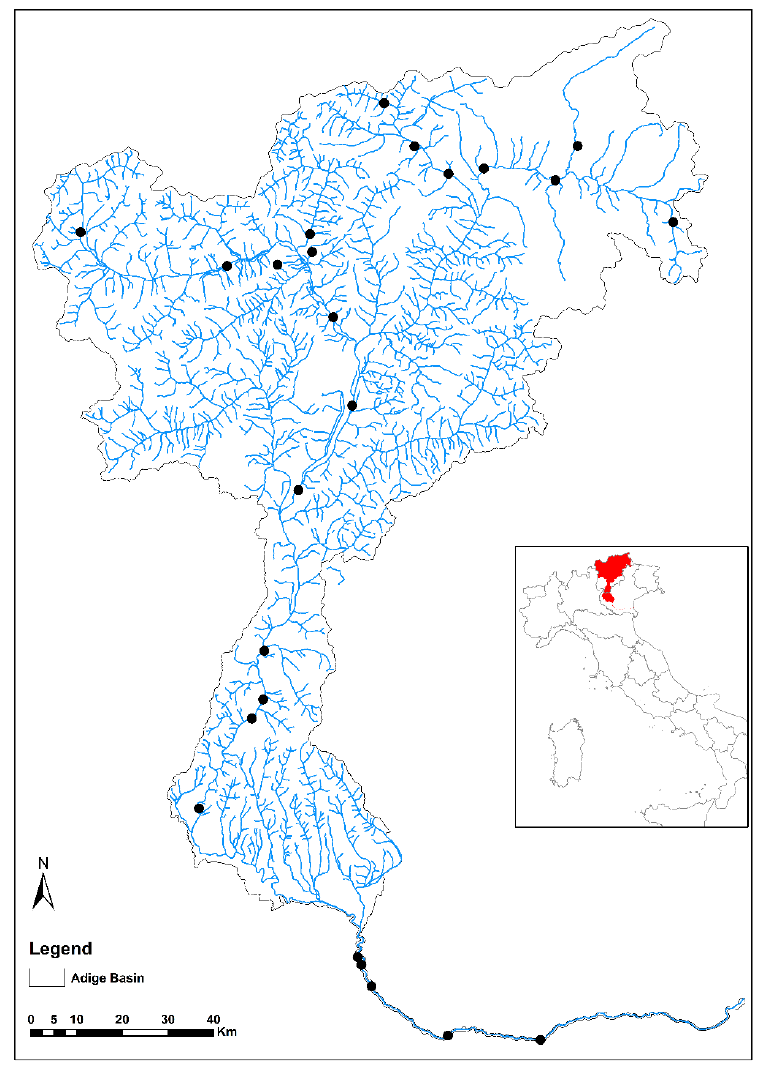
Figure 1. Sampling stations within the river network of the Adige basin. Table 1. List of the taxa recorded in the analysis. The classification was performed at Genus level when possible. Alterna- tively, coarser taxonomic levels are